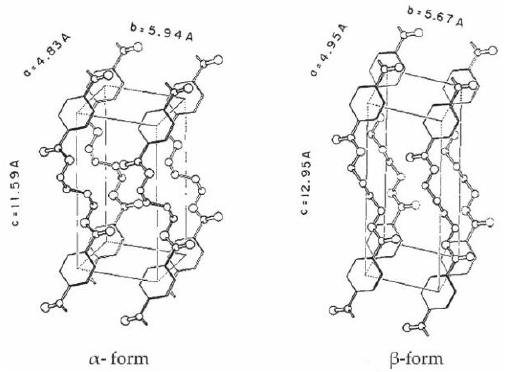
Figure 2. Two crystalline forms of the reversible molecular structure of PBT polymer elastic fiber: left α -form (after relaxation) and right β -form (under tension) [9].